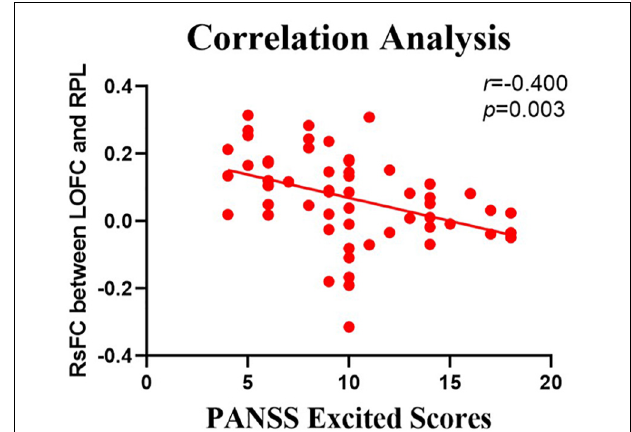
FIGURE 4 | Negative correlation between the resting-state functional connection (rsFC) values and the severity of excited symptoms in the FES. The X-axis is the score of the excited factors of the PANSS scale, and the Y-axis shows the functional connectivity of the left orbitofrontal cortex (LOFC) and right paracentral lobule (RPL) (after correcting for positive symptoms, age, gender, education, and illness duration).